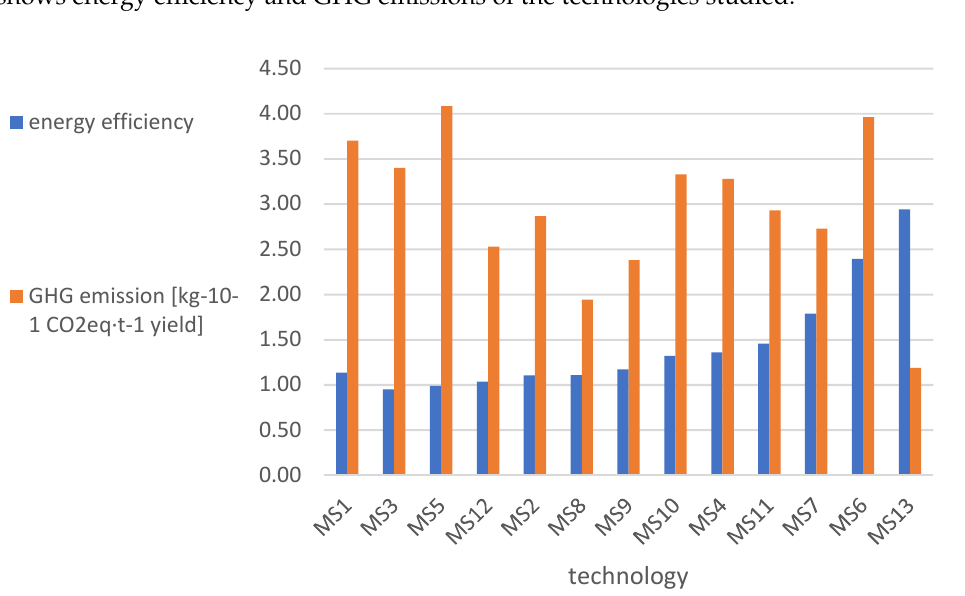
Figure 4. Energy efficiency and GHG emissions in silage maize production technologies.